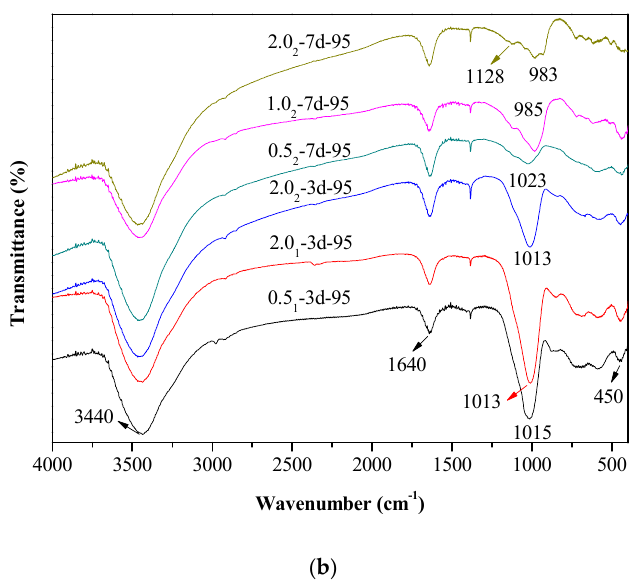
Figure 3. Fourier transform infrared spectroscopy (FTIR) spectra of K-A-S-H samples ( a ) synthesized by reaction at temperatures lower than 95 °C, ( b ) synthesized by reaction at 95 °C.